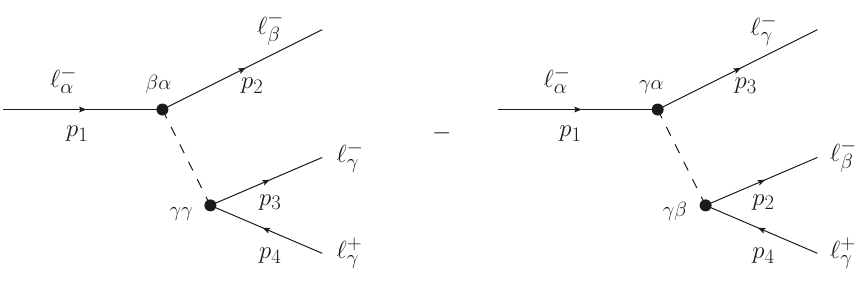
→ ‘ − ‘ − ‘ + described by α γ γ β